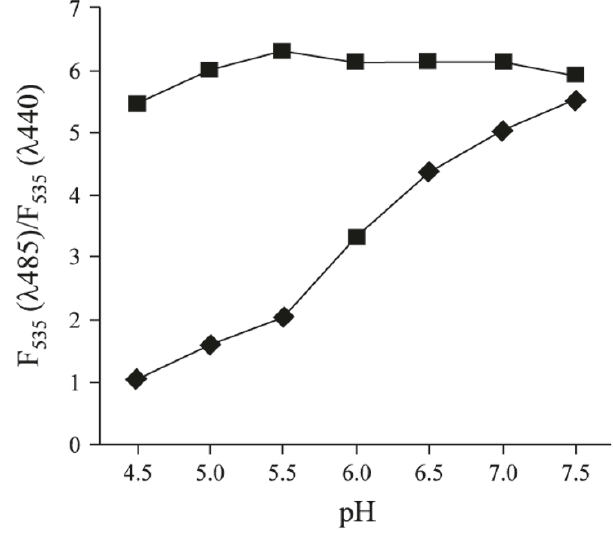
Figure 8 Effect of pH on the fluorescence of oxidized Oxy- BURST Green H 2 HFF BSA. Oxidized OxyBURST Green H 2 HFF BSA ( (cid:3) ) and 5-(and -6)-carboxyfluorescein ( ♦ ) were prepared in MES buffer solutions at various pHs, to a final concentration of 78 µ g/ml and 4.2 µ M respectively. The ratio of emission fluorescence at λ 535 upon excitations with λ